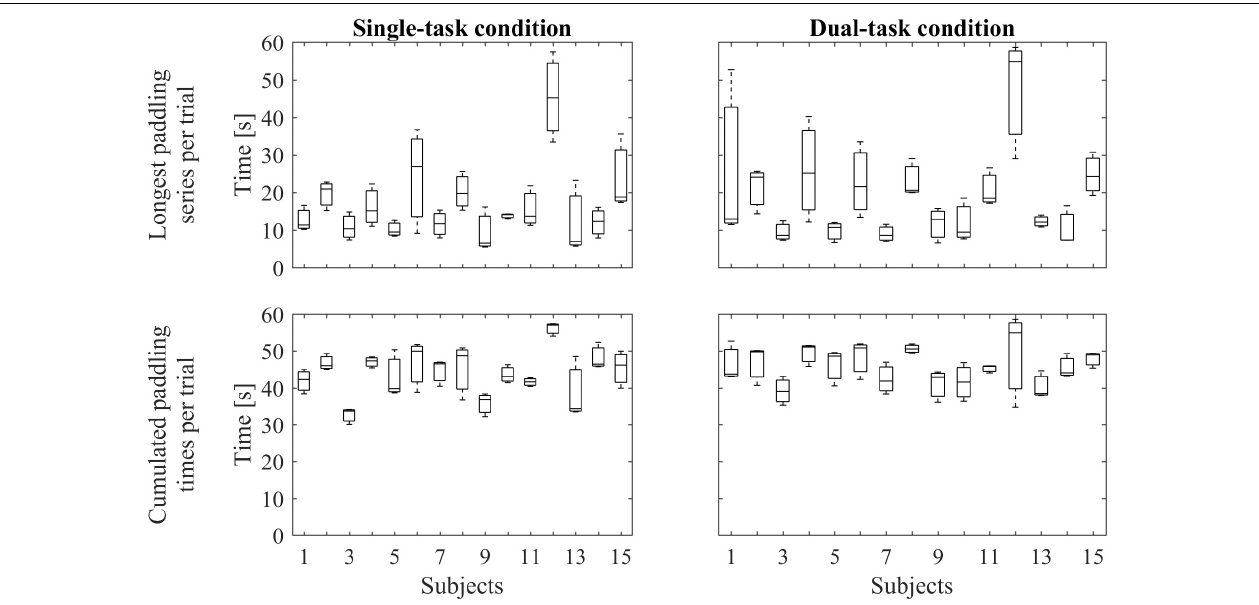
FIGURE 2 | Paddling performance. The upper row represents boxplots of the longest individual paddling run per trial under single-task condition (Left) and under dual-task condition (Right) . The lower row depicts boxplots containing the cumulated durations of the individual paddling runs per trial under single-task condition (Left) and under dual-task condition (Right) . In every boxplot, data from three trials are included.